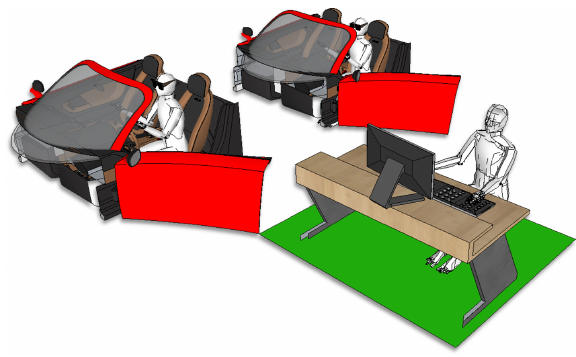
Figure 2. Training session including one trainer and two